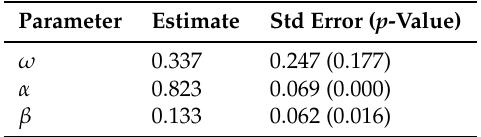
Table 1. Model estimates for China, with standard errors and p